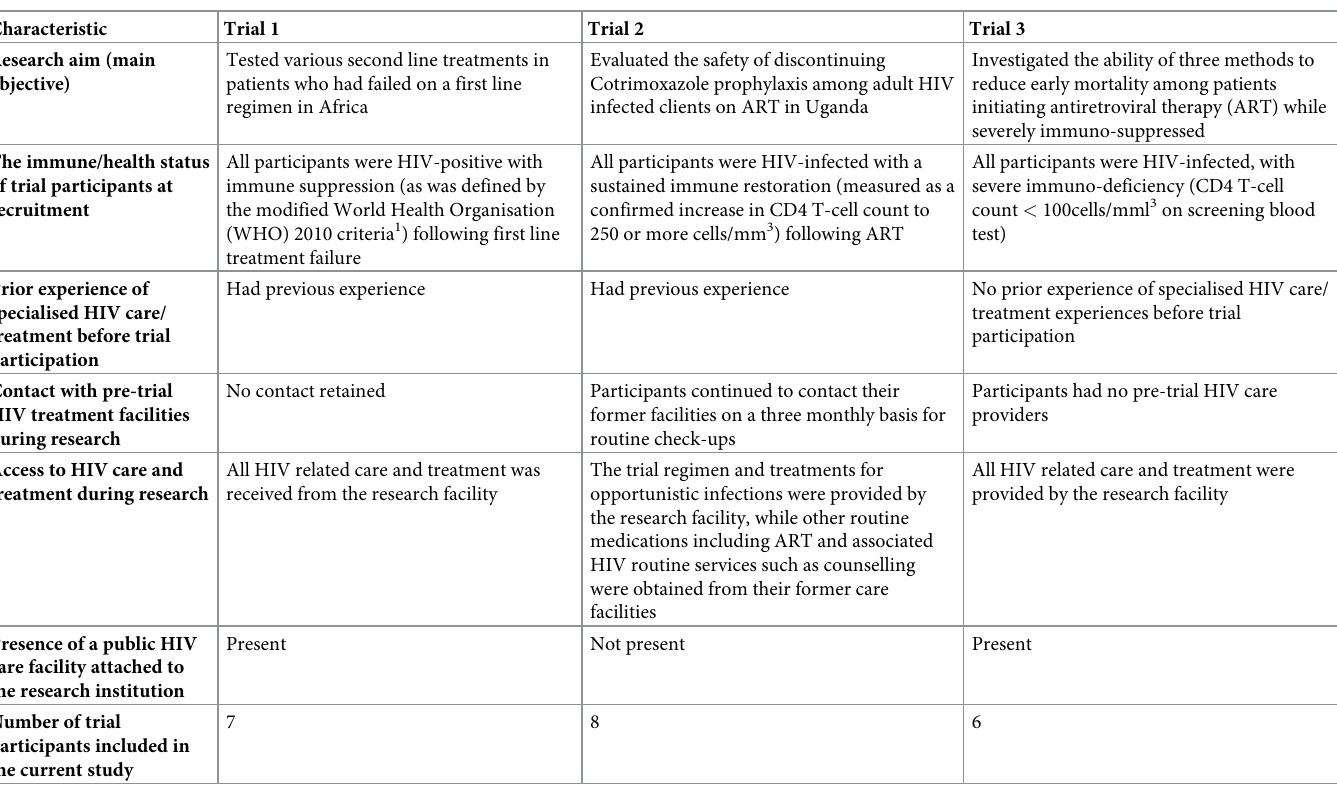
Table 1. Characteristics of included